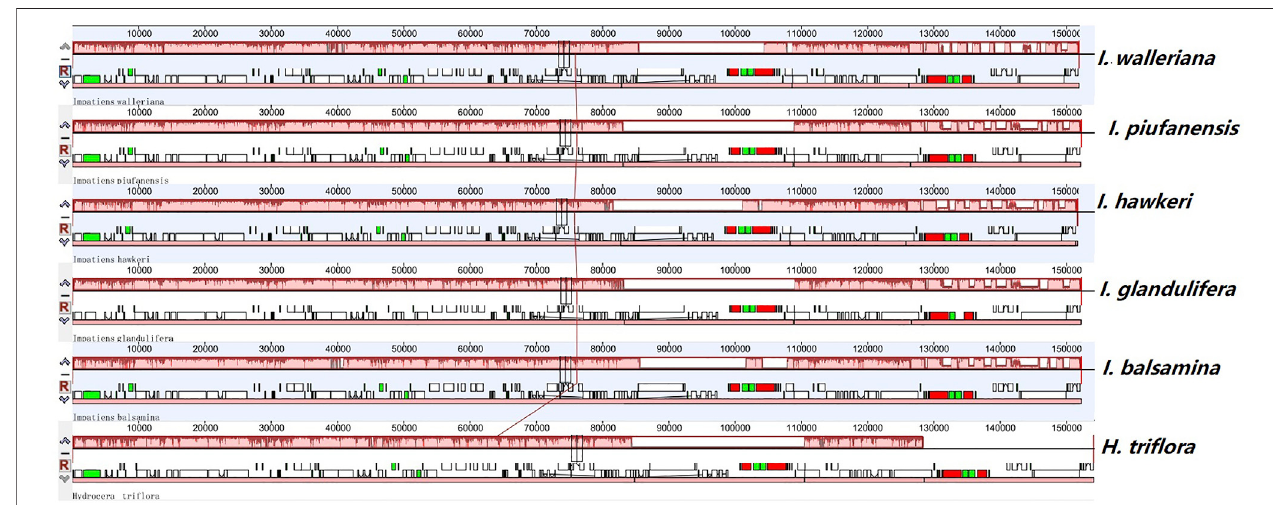
Frontiers in Genetics |